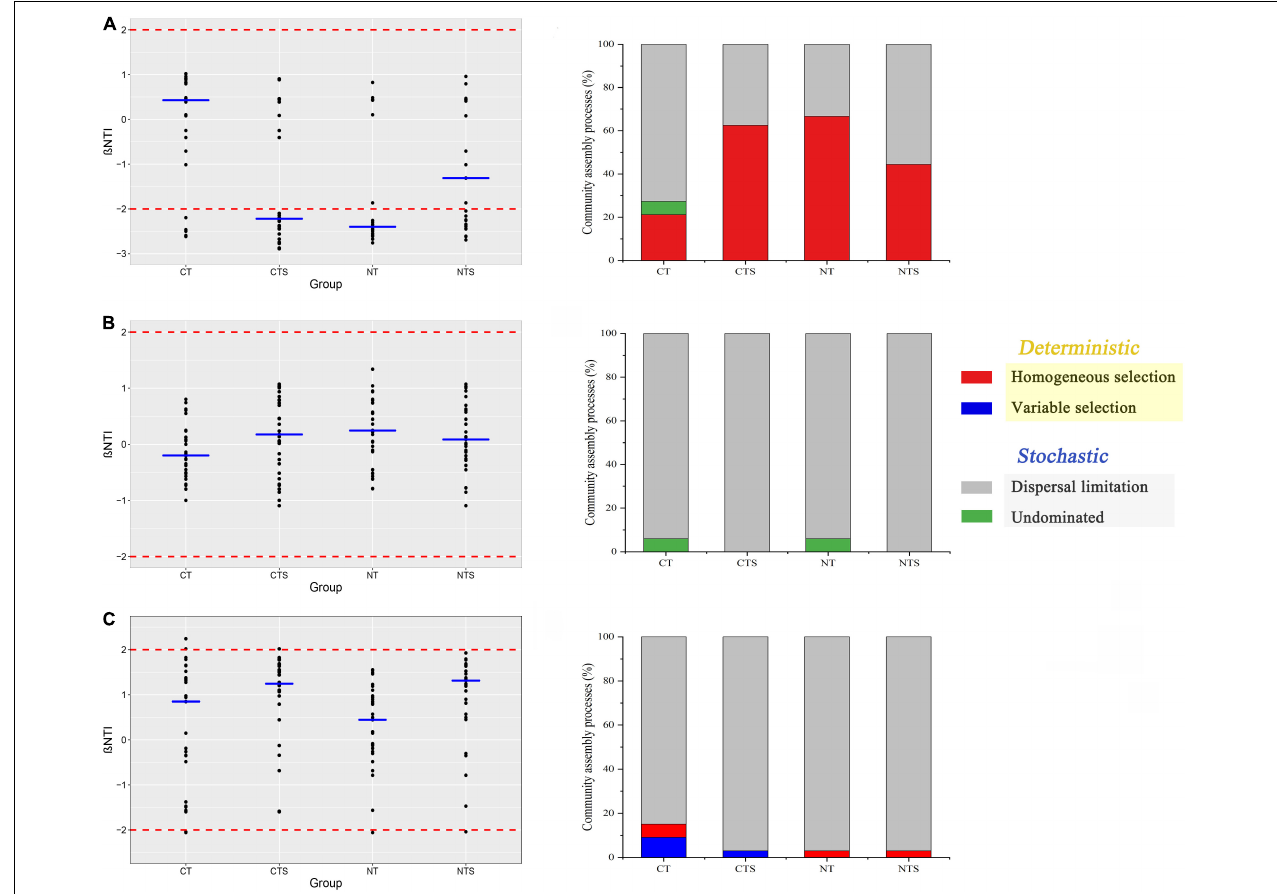
FIGURE 5 | Scatter plot of β NTI values and quantitative analysis of the assembly processes that govern the turnover of abundant (A) , intermediate (B) and rare (C) taxa communities in four treatments. The blue line represents the median values of each